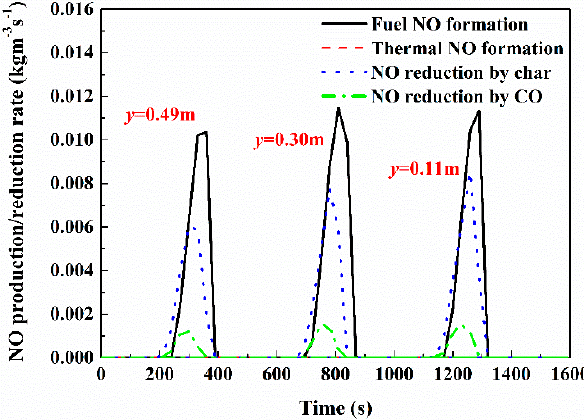
Figure 3. The NO formation/reduction rate on the central axis of the sintering bed (base case).